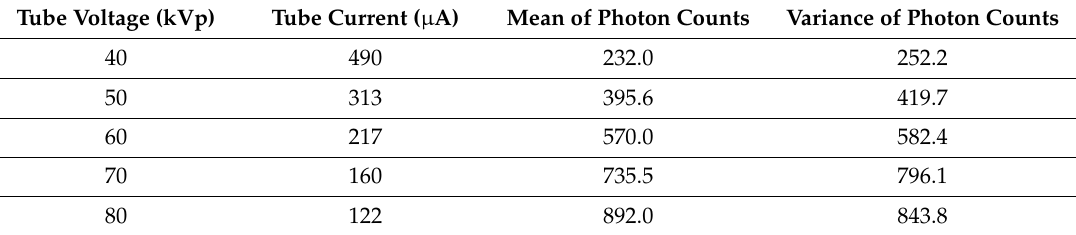
Table 1. Mean and variance of the photon counts at a good pixel in 400 measurements. The exposure time was 1 s and the threshold DAC was 600.